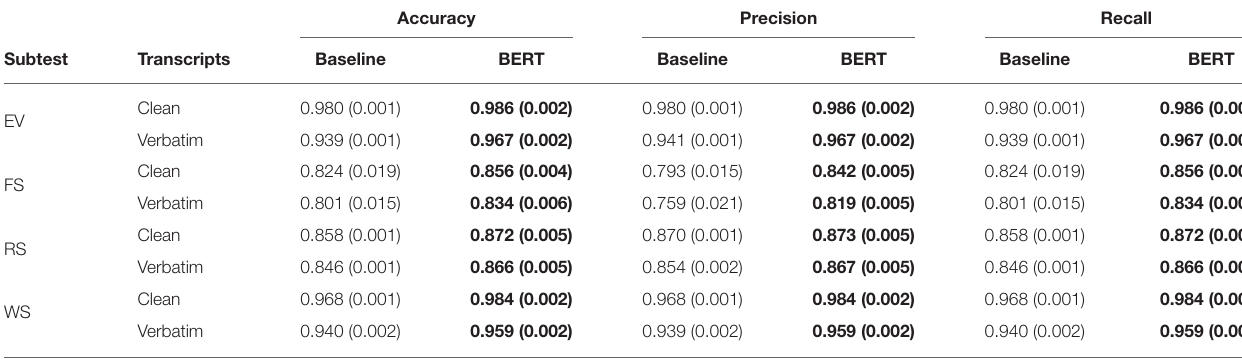
TABLE 2 | Mean (and standard deviation) of accuracy, precision, and recall measures for item-level scores.